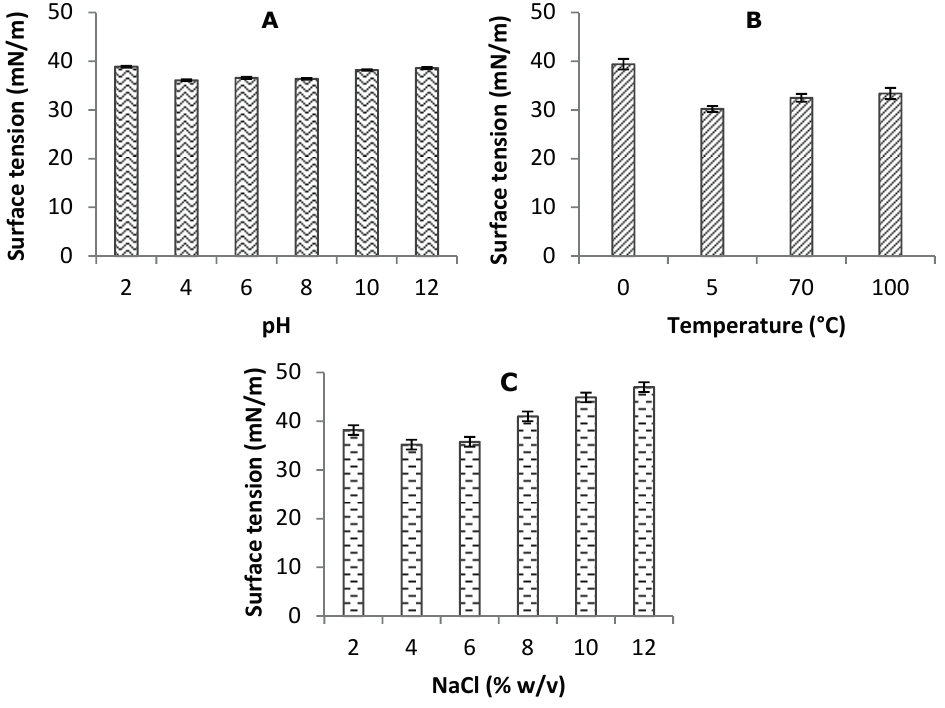
Figure 4. Stability of surface tension of biosurfactant produced by Cunninghamella chinulata using corn steep liquor (CSL) and soybean oil waste (SOW). Influence of pH ( A ); temperature ( B ); and sodium chloride concentrations ( C ) on surface tension